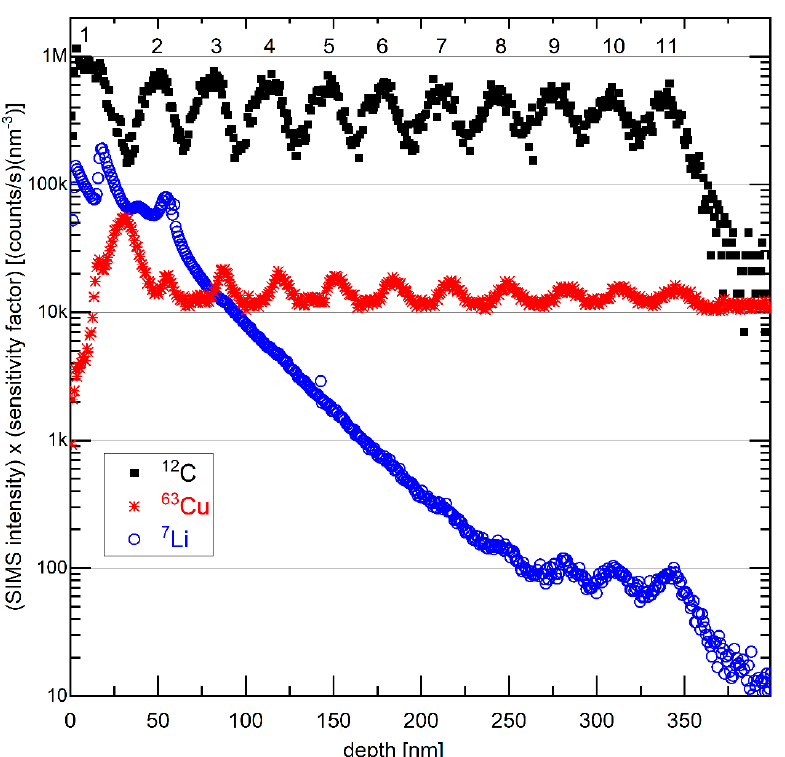
Figure 13. SIMS depth profiles of 7 Li, 12 C, and 63 Cu isotope on the electrode with a C/Cu ML after 542 cycles, washing, and air exposure for 15 months. The intensity is multiplied by the corresponding sensitivity factor. The numbers 1 to 11 denote the presence of eleven layers with a strong C signal. A color version of this figure can be viewed online.